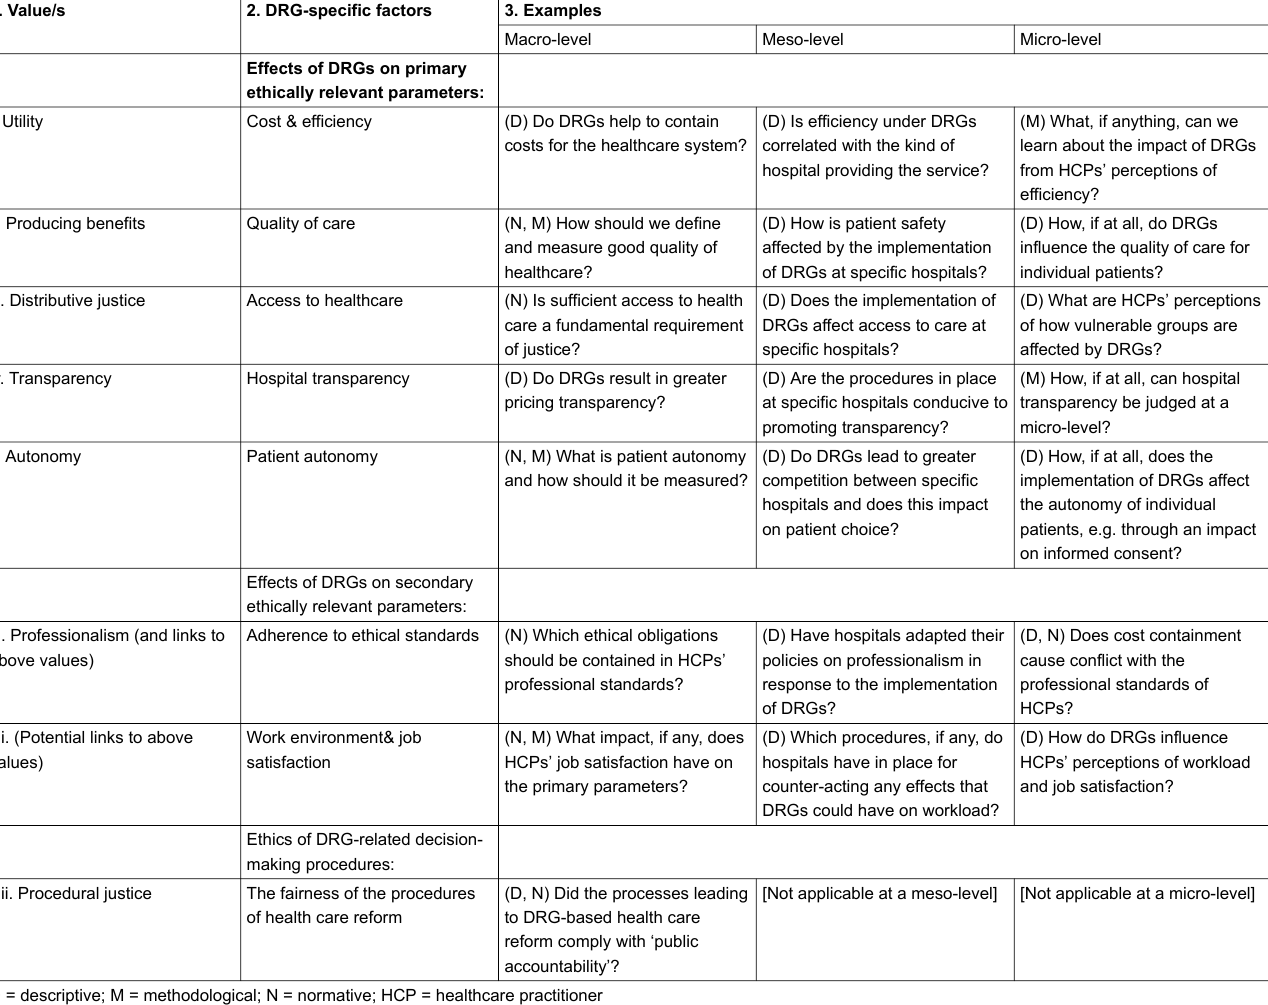
Table 1 : Matrix for identifying the ethical implications of the implementation of DRGs. Reprinted from Fourie C, Biller-Andorno N, Wild V. Systematically evaluating the impact of diagnosis-related groups (DRGs) on health care delivery: a matrix of ethical implications. Health Policy. 2014;115(2-3):157-64, with permission from